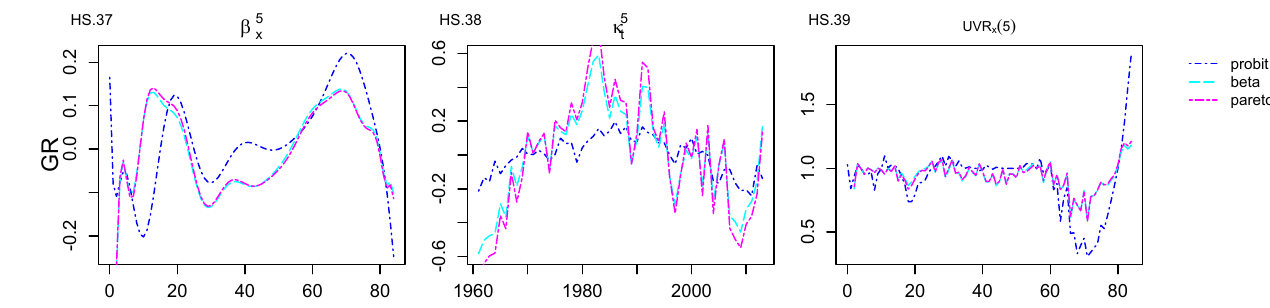
Figure A5. Fifth age-period component for GR